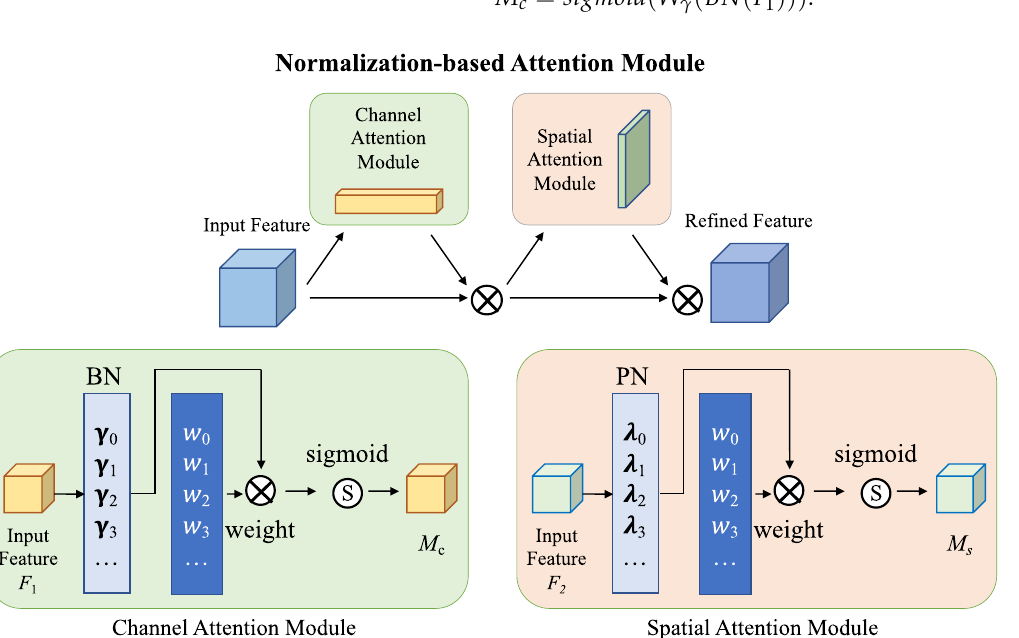
Figure 2. The architecture of the NAM. Two consecutive attention sub-modules refine feature maps in channel and space, respectively.